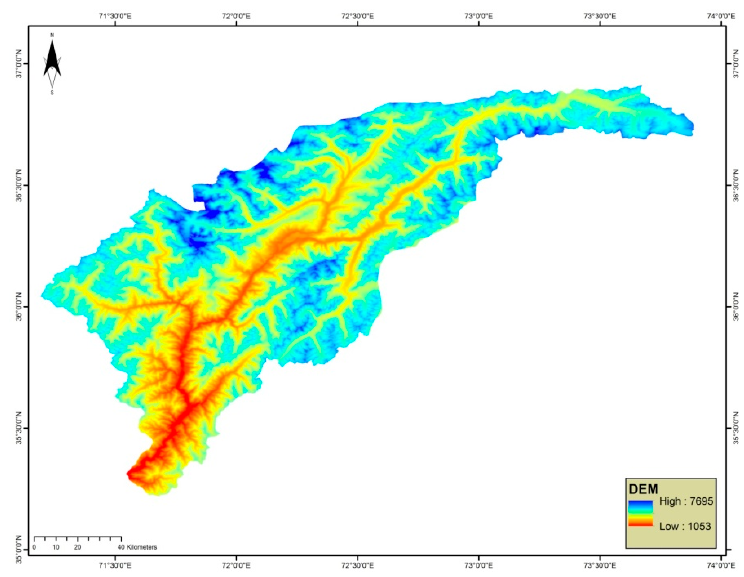
ISPRS Int. J. Geo-Inf. 2020 , 9 , x FOR PEER REVIEW Figure 2. Digital Elevation Model (DEM) of the study area. Figure 2. Digital Elevation Model (DEM) of the study area.